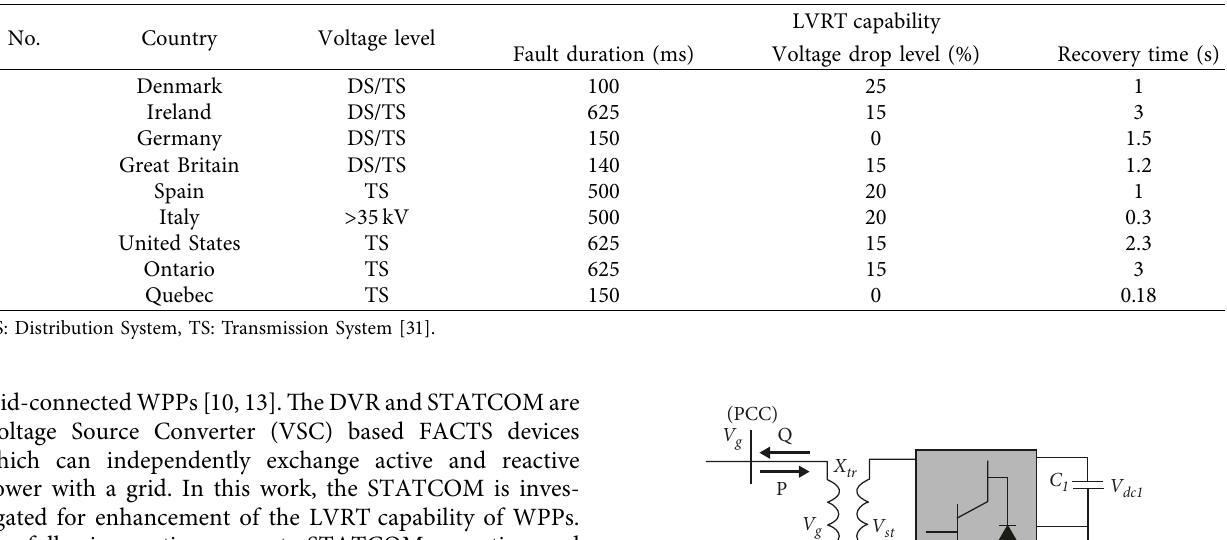
Table 1: LVRT capability requirements for various